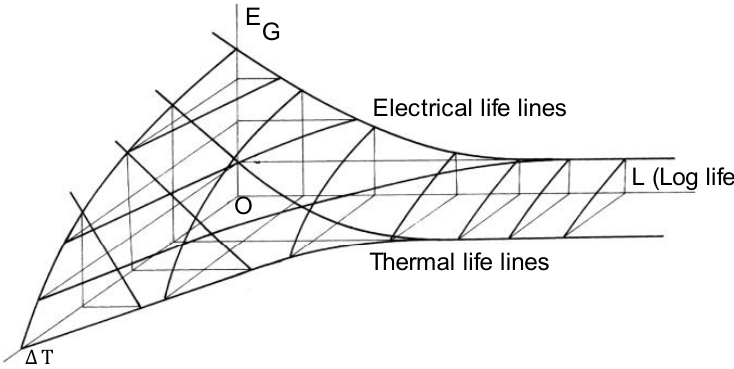
Figure 9. Life surface graph representing linear and isochronal lines adapted with permission from [31].